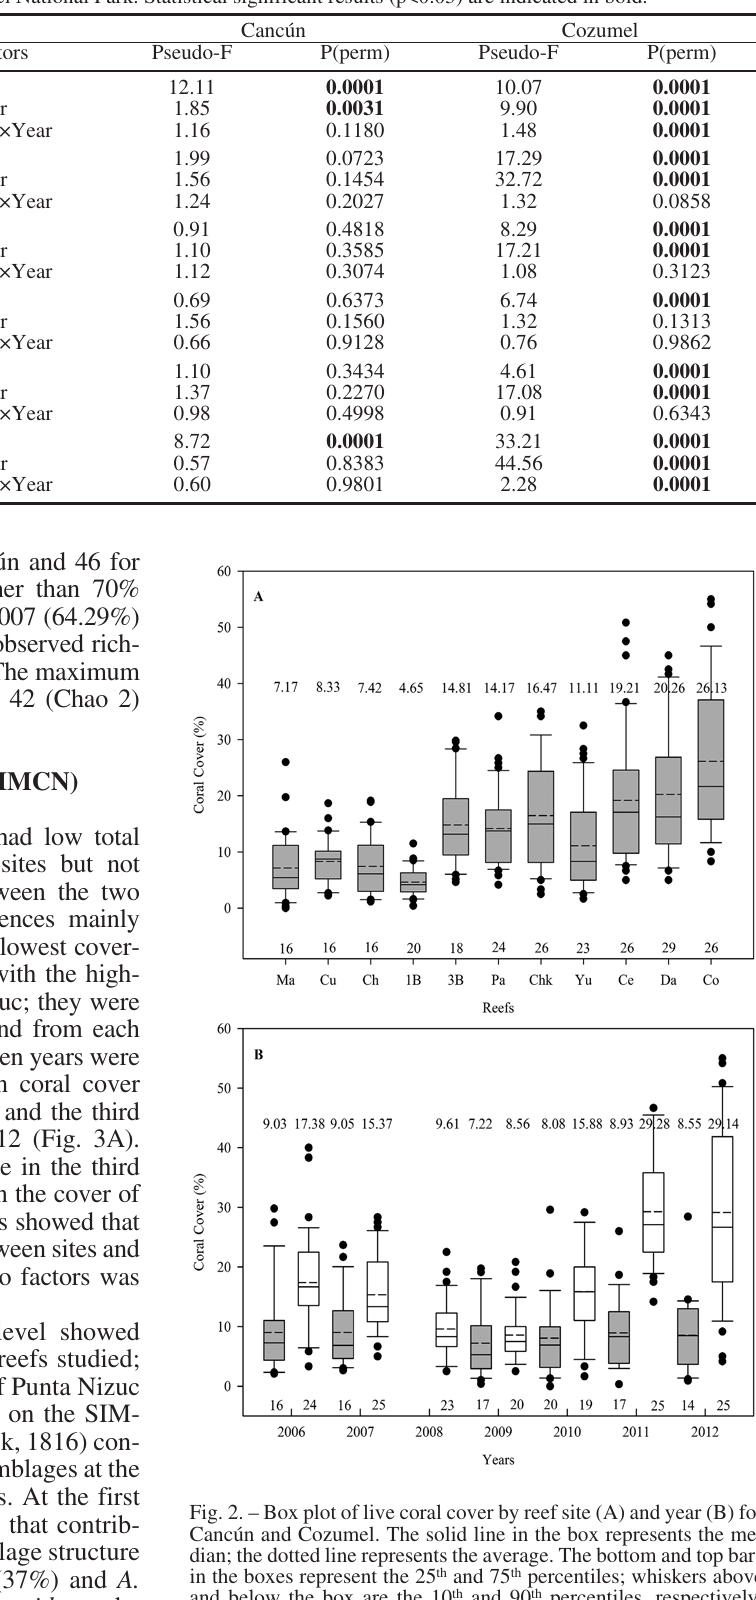
Table 1. – Summary of two-way crossed factors and fixed effects ANOVAs and PERMANOVA of the coral assemblages and diversity index of Cancún National Park and Cozumel National Park. Statistical significant results (p<0.05) are indicated in bold.